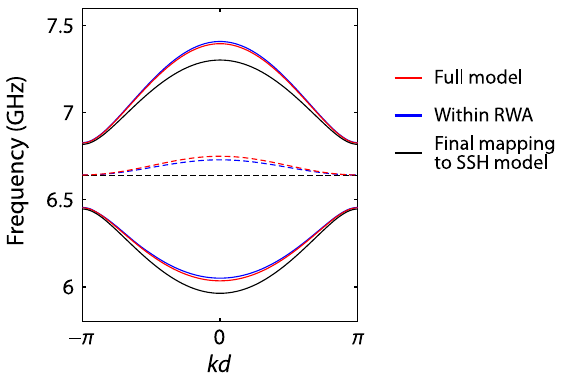
FIG. 6. Band structure of the realized topological waveguide under various assumptions discussed in Appendix B. The solid lines show the dispersion relation in the upper (lower) passband, ω ð k Þ : full model without any assumptions (red), model within (cid:4) RWA (blue), and the final mapping to SSH model (black) in the weak coupling limit. The dashed lines indicate the uncoupled resonator frequency ω 0 ð k Þ under corresponding